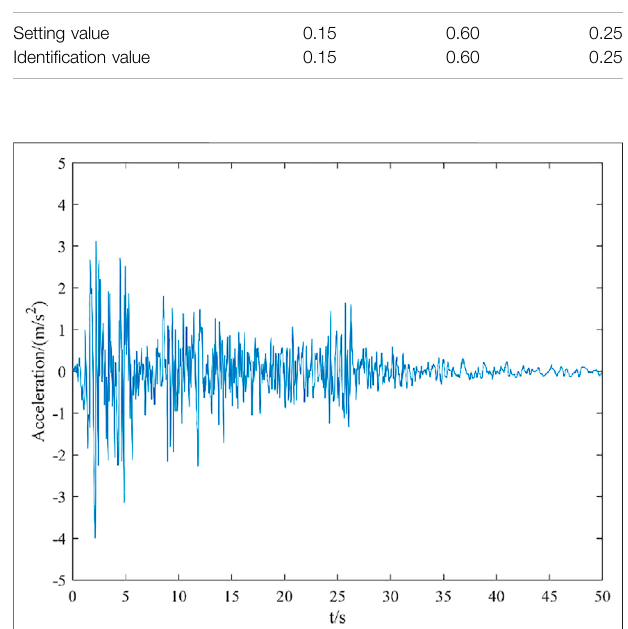
FIGURE 13 | EL Centro seismic wave time history